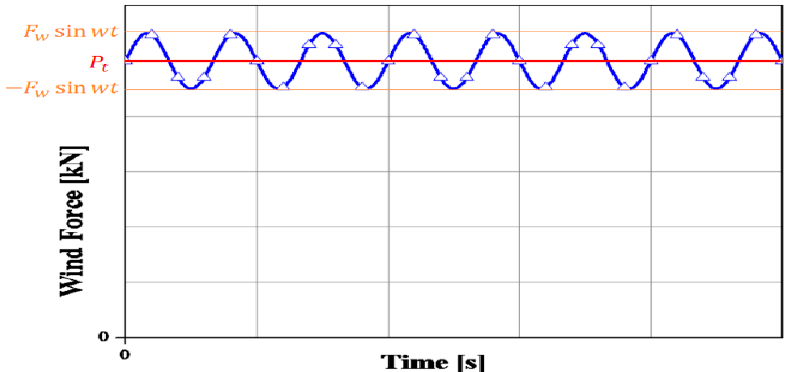
Figure 5. The wind force with a frequency component.